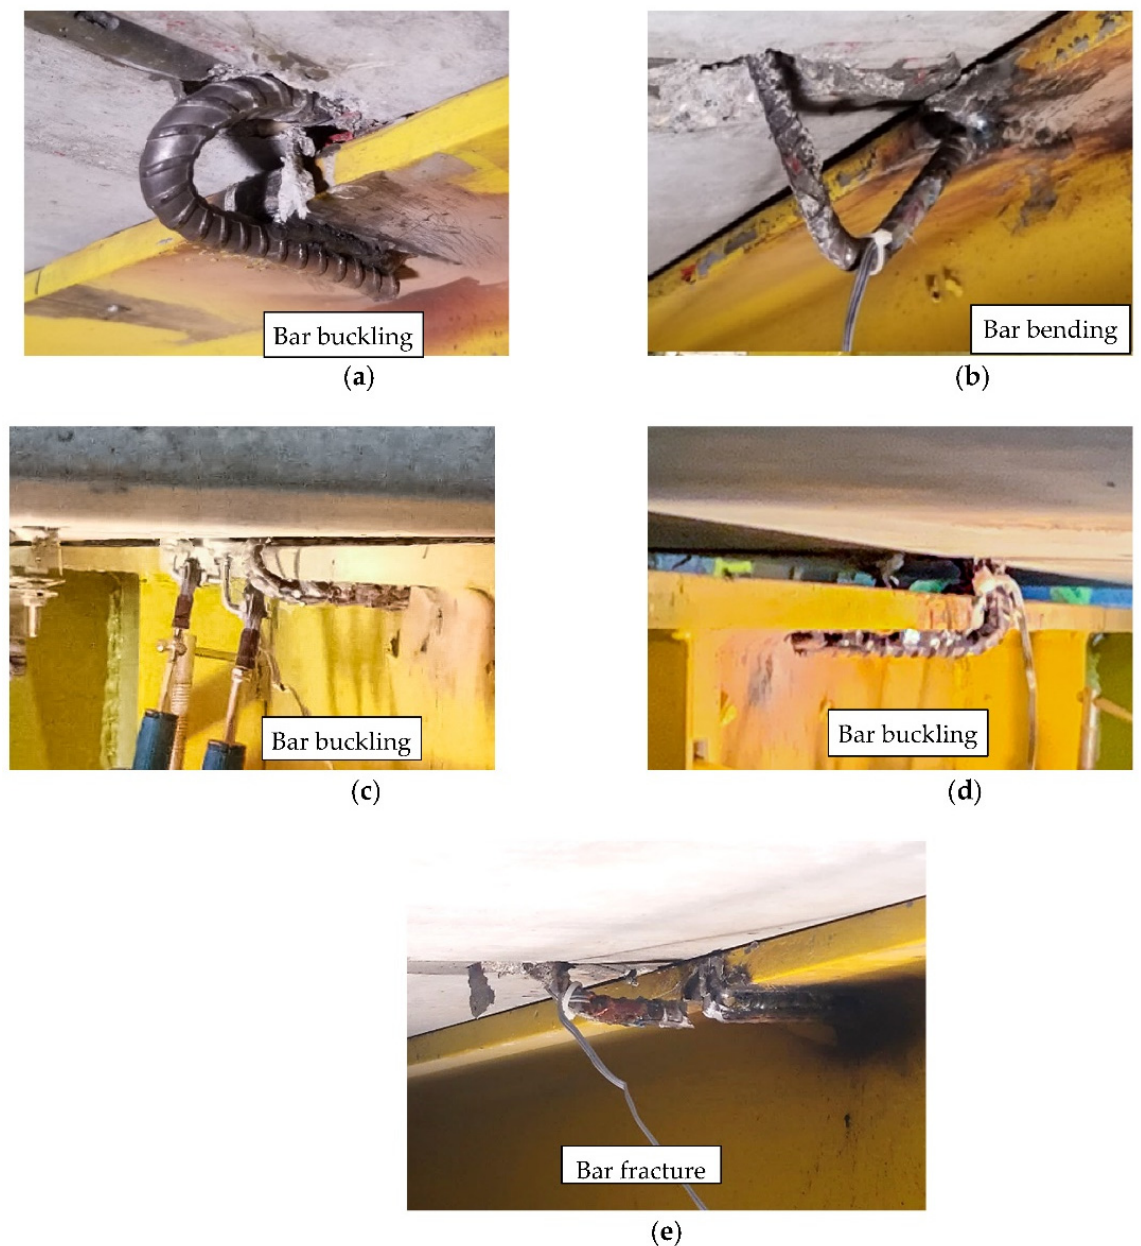
Figure 7. Mode of failure for end-bearing specimens tested under pushing forces (parallel and normal): ( a ) EB-CN-90 (pushing/normal), ( b ) EB-CN-45 (pushing/normal), ( c ) EB-CN-90R (pushing/normal), ( d ) EB-CN-90R (pushing/normal), and ( e ) EB-CP-90 (pushing/parallel). When tested under compression (pushing), the side-bearing connection (SB-CN-90) demonstrated a similar failure mechanism to that of its end-bearing counterpart specimen (EB-CN-90), however, no bar rupture occurred. The test was halted after a load drop of 70% of the maximum load and noticeable bar distortion (Figure